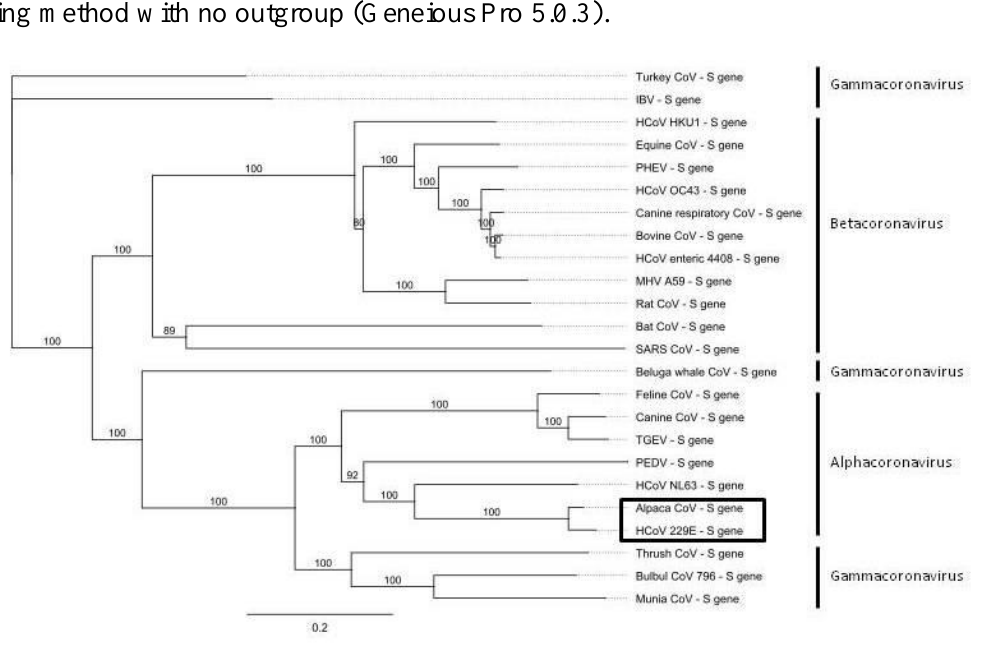
Figure 4. Phylogenetic tree analysis of the nucleocapsid genes from different coronaviruses. Alignments were performed using Clustal W, and the tree was created using a Neighbor Joining method with no outgroup (Geneious Pro 5.0.3).